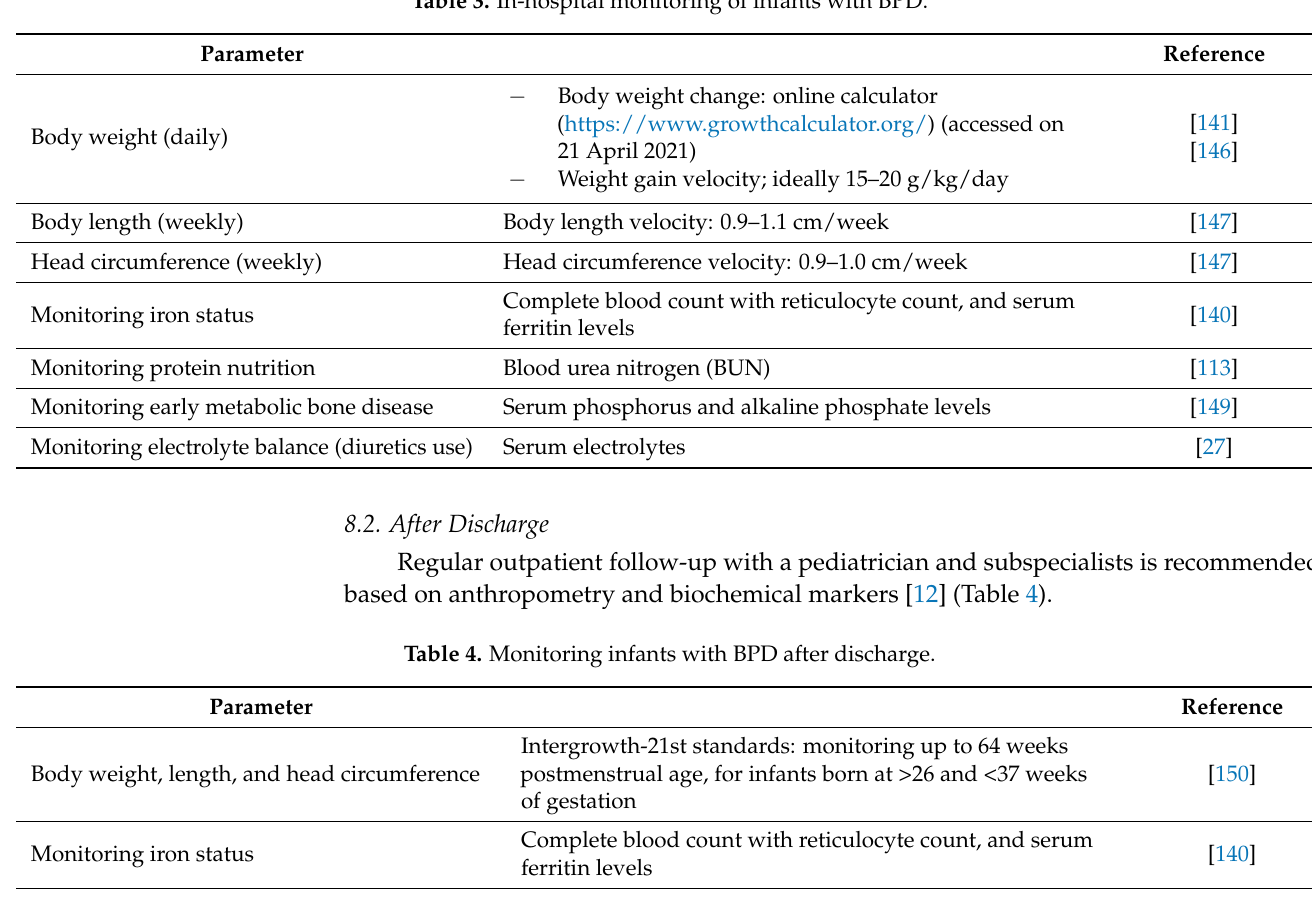
Table 3. In-hospital monitoring of infants with BPD.